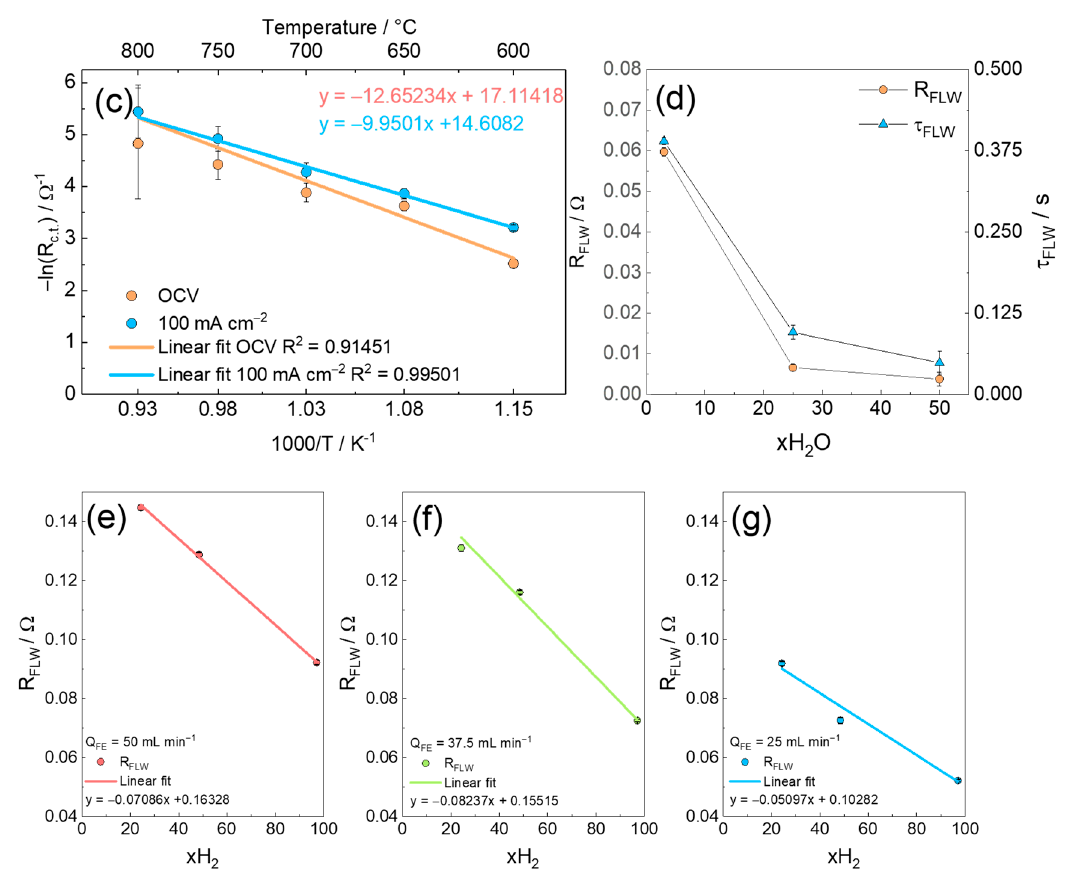
Figure 8. ( a ) Nyquist plot, fit results and ECM, ( b ) relative residuals of the CNLS-fit result. AC response in ( a ) and ( b ) was acquired at T 600 °C, Q FE = 50 mL min − 1 xH 2 = 97%, xO 2 =21%, and j = OCV. ( c ) Arrhenius plot ln(Rc.t. − 1 ) vs. 1000/T with linear fit. R FLW vs. ( d ) xH 2 O and ( e ), ( f ), and ( g ) vs. xH 2 (xH 2 O = 3%, balanced with N 2 ). The latter were acquired with a Q FE of ( e ) 50 mL min − 1 , ( f ) 37.5 mL min − 1 , and ( g ) 25 mL min − 1 , T = 800 °C, j = OCV.